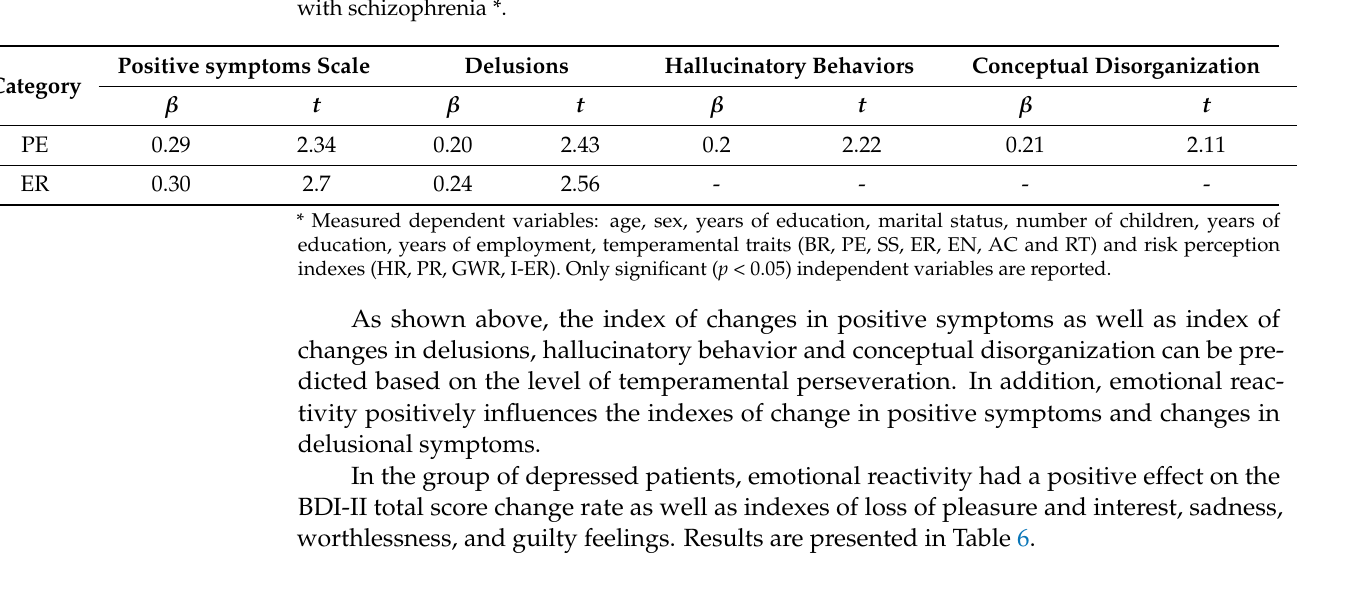
Table 6. Multiple regression analysis of indexes of significant symptoms change in depressed patients